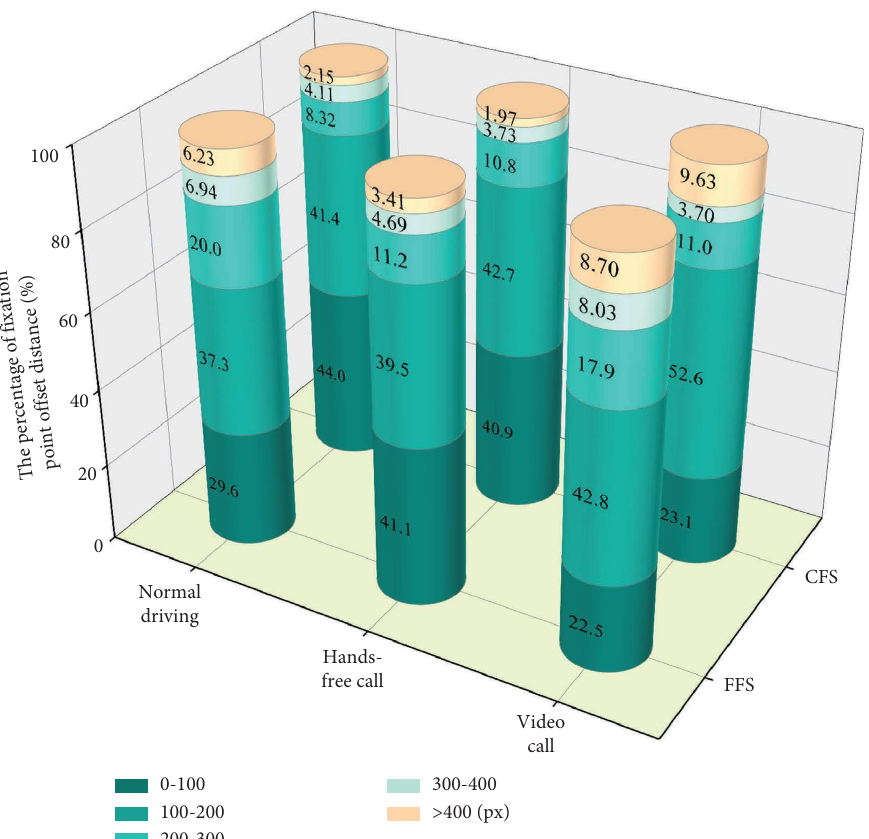
Figure 3: Percentage of fxation point ofset distance in each interval for diferent trafc conditions and driving